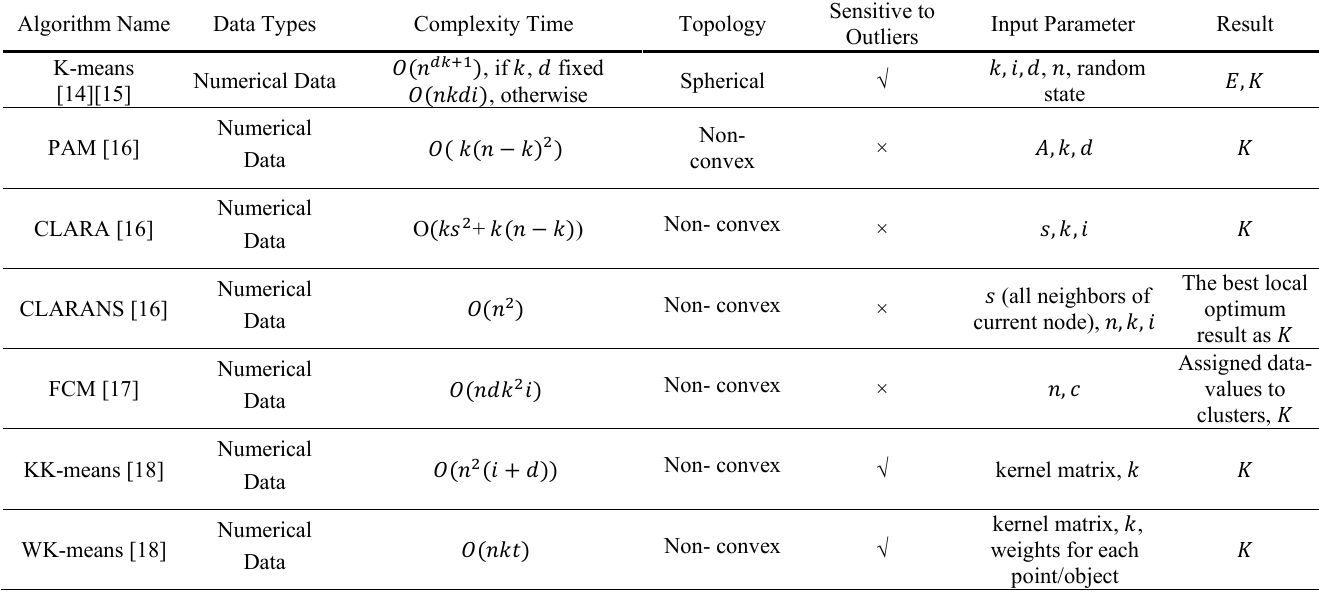
Table 1. Centroid-Based Clustering General